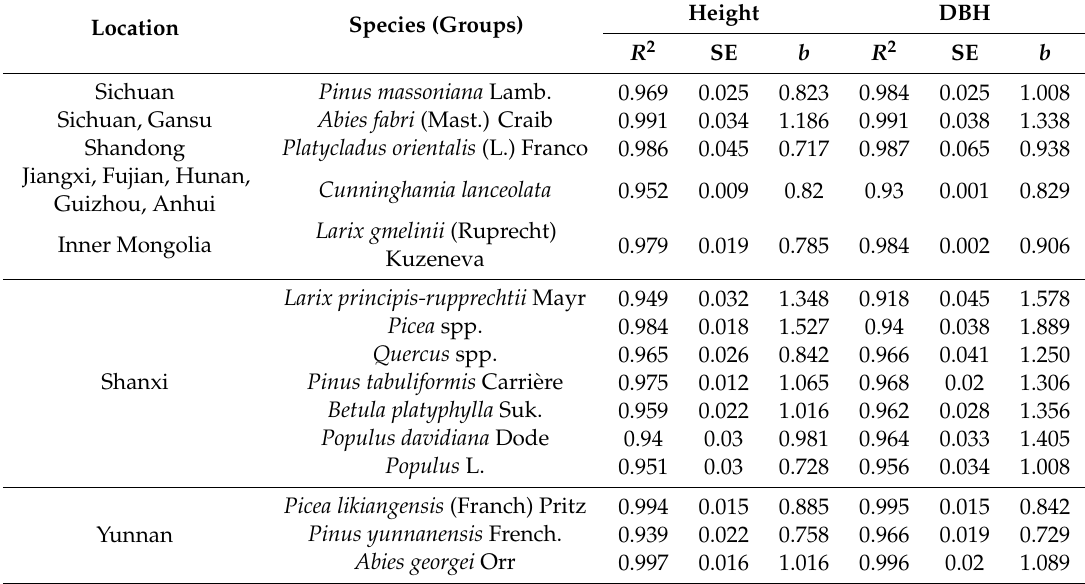
Table 4. Fitting results for the di ff erence equation for di ff erent